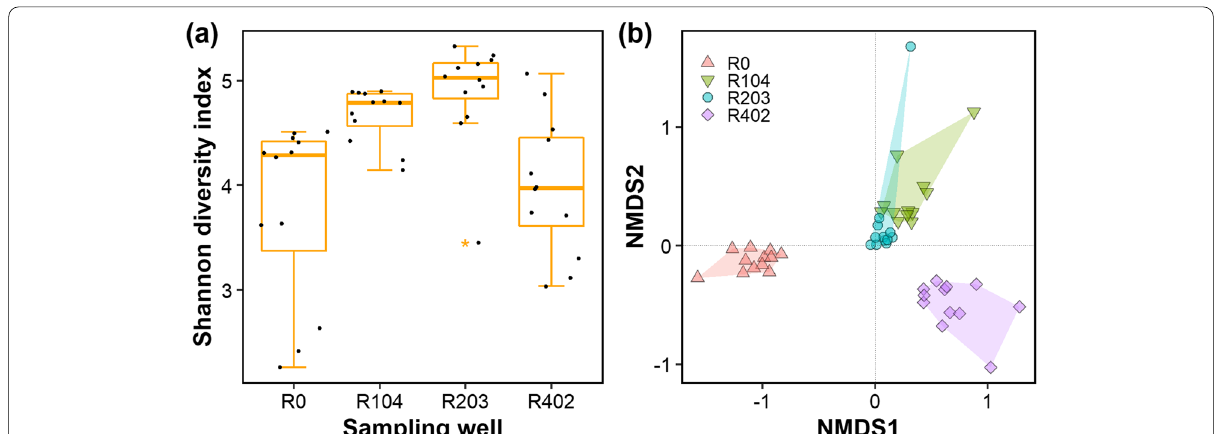
Fig. 2 a Shannon diversity index across the sampling wells, calculated from data collected in the period 2018-2019. Each point represents a sample. The asterisk indicates an outlier. b Nonmetric multidimensional scaling (NMDS) plot of sites based on Bray-Curtis dissimilarity distance. R0: background well; R104: proximal well; R203: intermediate well; R402: distal well